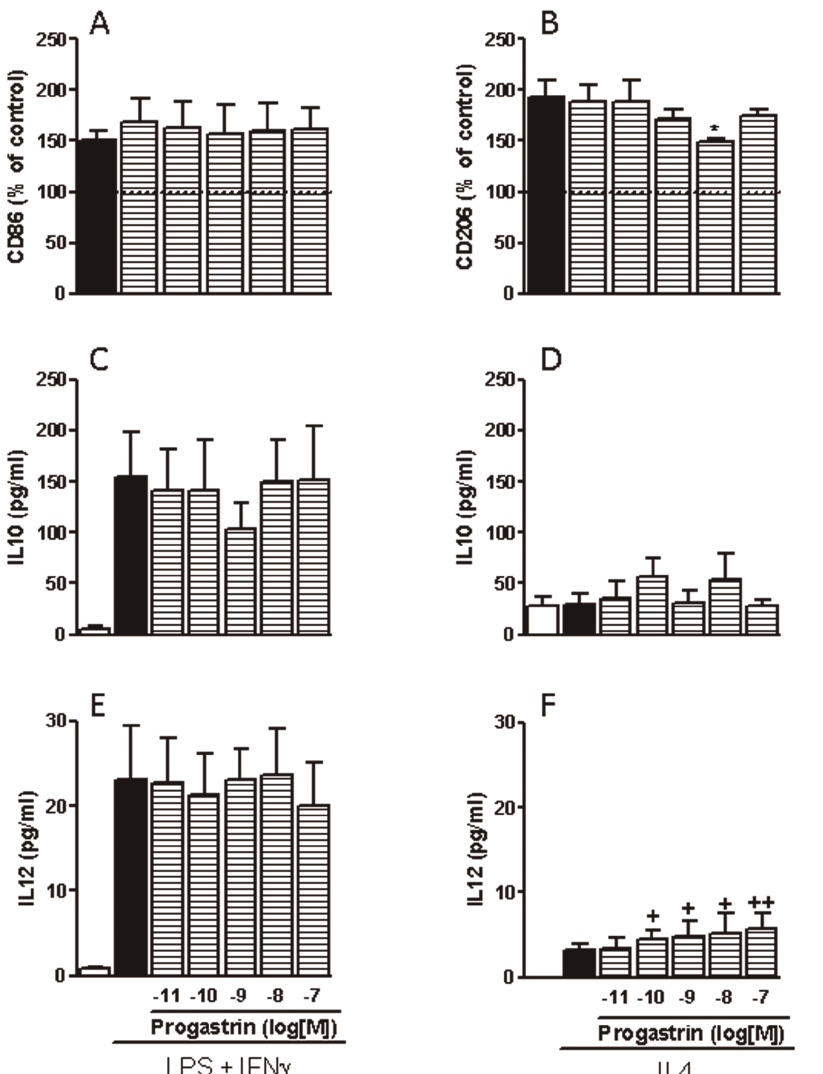
Figure 4. Influence of progastrin on human M1 and M2 macrophages. Human monocyte-derived macrophages were stimulated with LPS plus IFN c to obtain a M1-phenotype or with IL4 to obtain M2-macrophages in the presence or absence of progastrin, and the resultant phenotype evaluated by analyzing the following parameters: expression of CD86 (A, n=3); expression of CD206 (B, n=5); secretion of IL10 (C, D, n=5); and secretion of IL12 (E, F, n=5). Bars represent mean 6 SEM. *P , 0.05 vs corresponding value in vehicle-treated cells; + P , 0.05 and ++ P , 0.01 vs corresponding value in control cells.